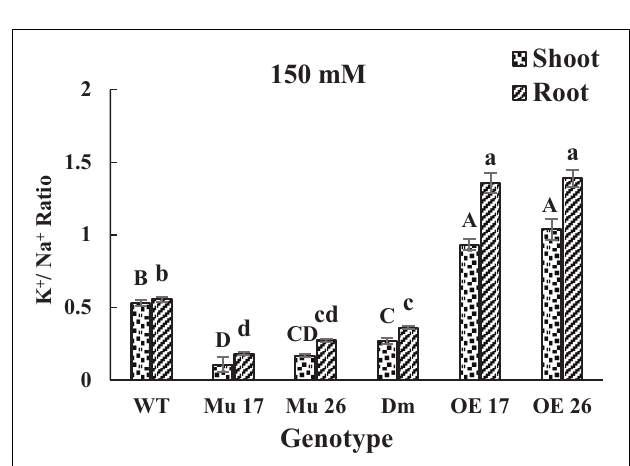
FIGURE 3 | The K + / Na + ratio in shoots and roots of genotypes at 150 mM NaCl stress. Wild-type (WT), overexpress (OE), single mutant (Mu), and double mutant (DM) genotypes of Arabidopsis thaliana purple acid phosphatase 17 ( AtPAP17 ) and 26 ( AtPAP26 ) genes. The significant mean differences ( P < 0.05) were separately shown for shoot and root with different uppercase and lowercase letters,